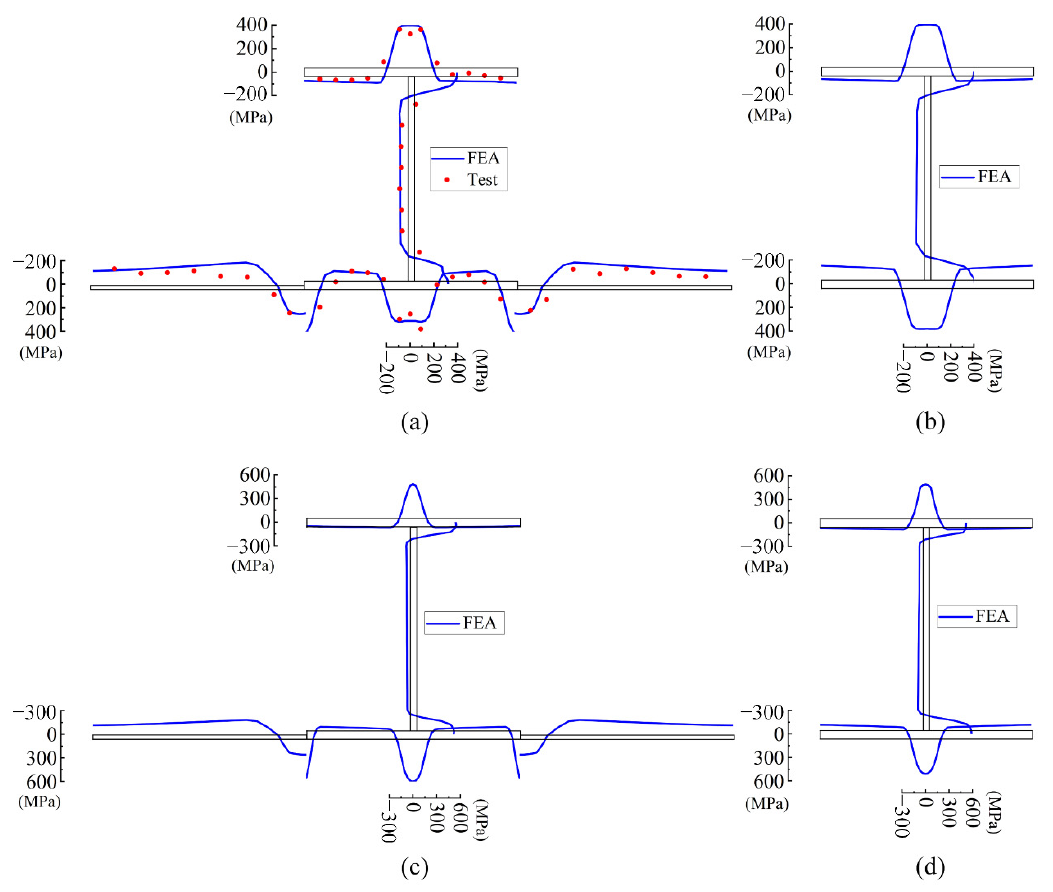
Figure 11. Residual stress distribution for model M2 (unit: MPa): ( a ) Comparison of measured and simulated values (nominal 460 MPa steel), ( b ) Simulated values of column section (nominal 460 MPa steel), ( c ) Simulated values of overall structural system (690 MPa steel column), and ( d ) Simulated values of column section (690 MPa steel).